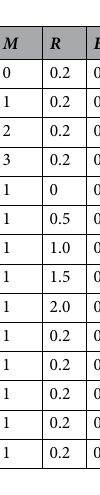
Table 3. Numerical values of Nusselt number θ ′ ( 0 ) for numerous values M , R , and Ec with n = 2, K = 0.2, (cid:31) = 0.5 and Pr = 10